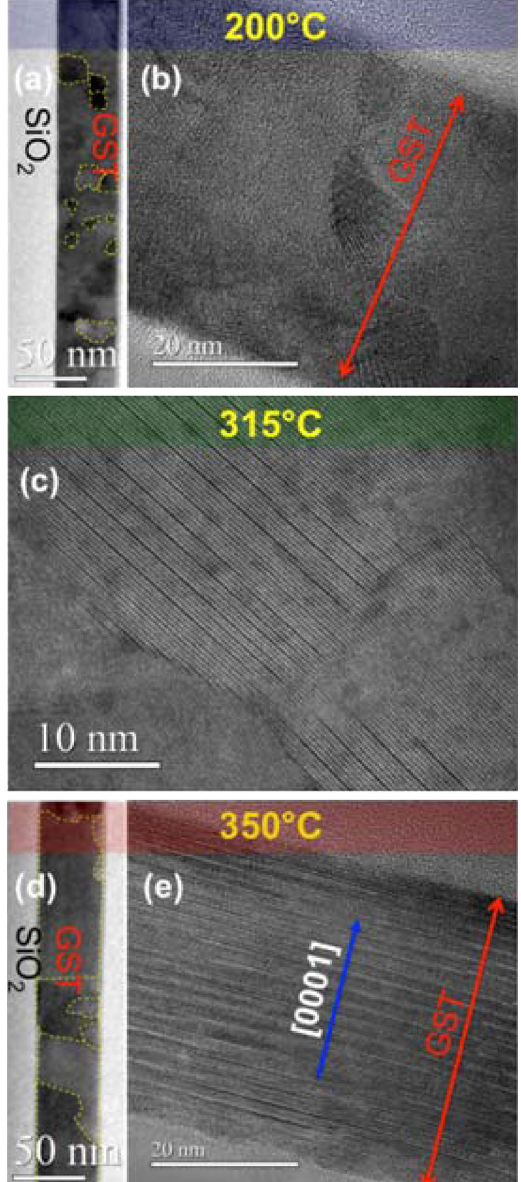
Figure 6. Evolution of the crystalline phases as a function of temperature for GST film on SiO 2 . ( a ) and ( b ) shows a TEM micrograph of a sample annealed at 200 °C. Fine randomly oriented grains with rocksalt structure are visible and grain boundaries are underlined in ( a ) by dashed yellow lines. ( c ) GST annealed at 315 °C, exhibiting both trigonal and rocksalt phase, with ordered vacancy layers or random vacancies. ( d ) and ( e ) shows the sample in the trigonal structure annealed at 350 °C. The presence of large grains ( > 50 nm) is shown by yellow dashed lines, indicating the grain boundaries in ( d ). {0001} planes parallel to the surface are preferentially